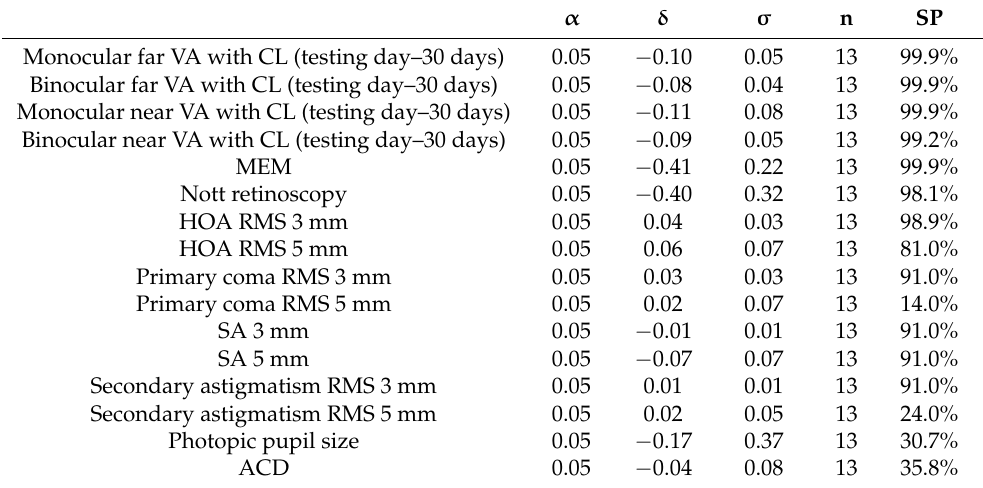
Table 5. Statistical power calculations associated with the analysis of those variables showing statistically significant changes. Abbreviations: α , type I error probability (probability of falsely rejecting the null hypothesis; δ , difference between means; σ , standard deviation of difference in the response of matched pairs; n, number of subjects; SP, statistical power; MEM, monocular estimation method; HOA, high order aberration; RMS, root mean square; SA, spherical aberration; ACD, anterior chamber